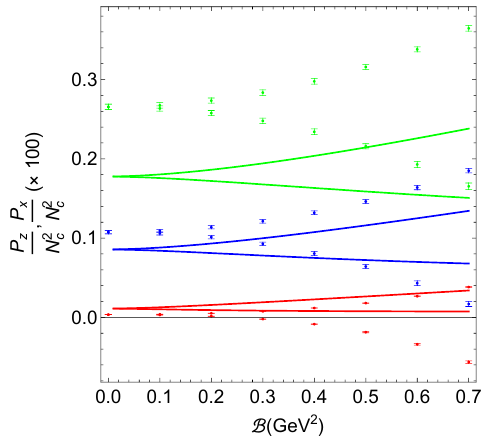
Figure 10 . Longitudinal pressure P z (upper solid line for a given colour) and transverse pressure P x (lower solid line for a given colour), both divided by N 2 fixed values of the temperature, compared with lattice results (dots with error bars), divided by N 2 = 3 2 , obtained in [74]. The red, blue and green colours correspond to T = 0 . 15 GeV , 0 . 25 GeV c and 0 . 3 GeV